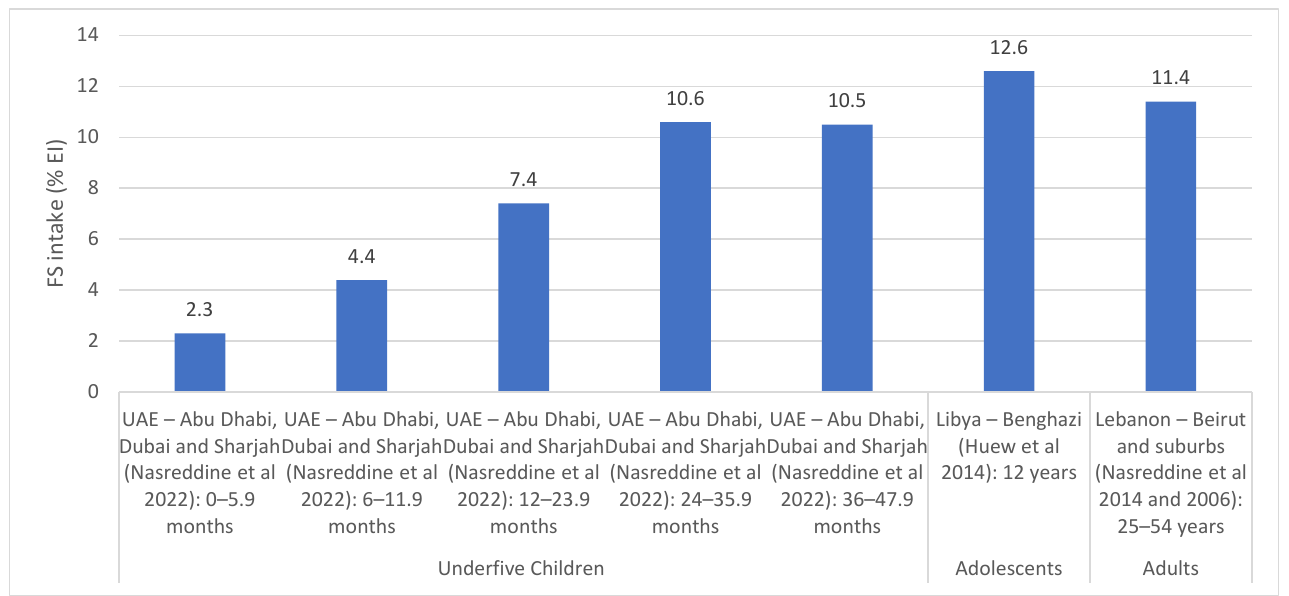
Figure 5. FS intake estimates (% EI) based on regional studies in countries of the EMR. Abbrevia-